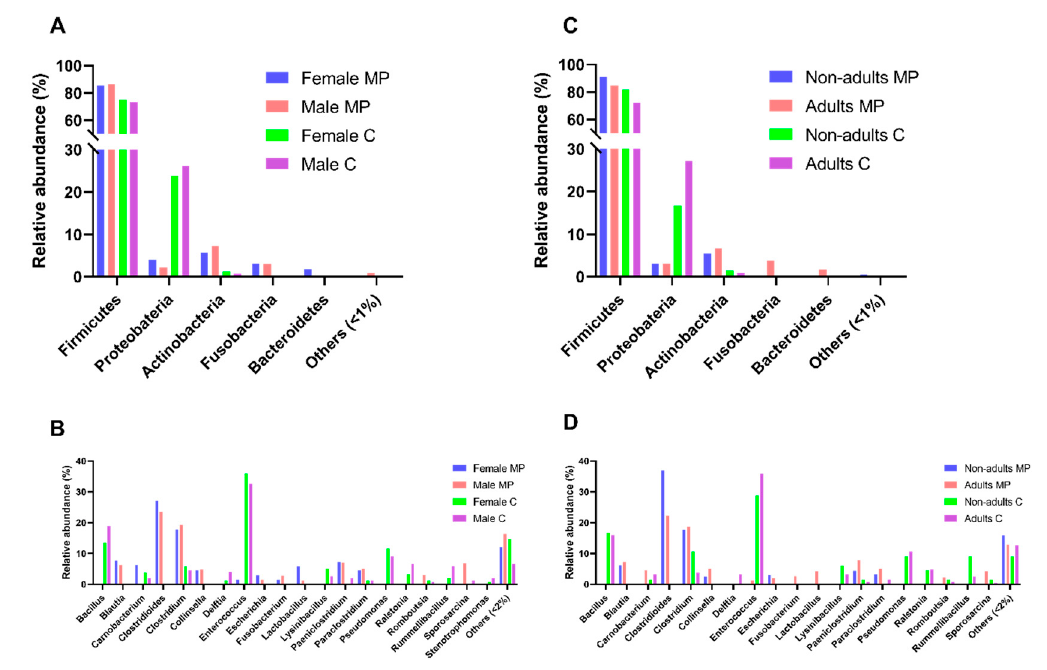
Figure 3. Comparison of the intestinal bacterial microbiota of Egyptian mongoose across sex and age classes, based on the datasets obtained through culturomics and microbial profiling [10] approaches. ( A ) Relative abundance on a phylum and ( B ) genus level for female and male individuals; ( C ) Relative abundance on a phylum and ( D ) genus level for nonadult and adult individuals.